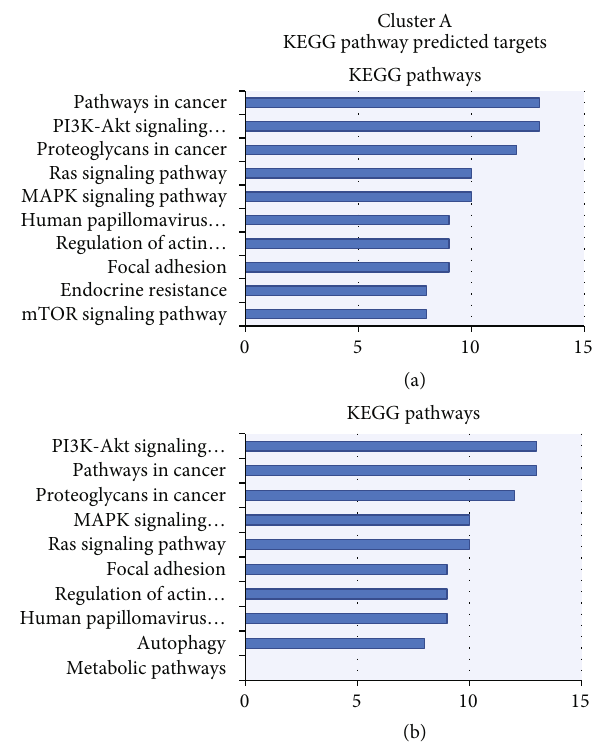
Figure 4: Distribution of enriched KEGG pathways of cluster A: 18 miRNAs consistently deregulated in AbP or recent T1D groups (13 of them being also deregulated in T1D 2-5y). The chart shows category rankings. The X -axis value represents the number of microRNA ’ s targets in the pathway and the Y -axis the pathways. (a) Represents the potential genes from up-expressed microRNAs. (b) Represents the potential genes from down-expressed microRNAs in comparison with controls. AbP group (individuals without diabetes expressing islet autoantibody); recent T1D group (newly diagnosed T1D patients with duration ≤ 6 months); T1D 2-5y group (patients with T1D with 2 to 5 years of duration); IAA: insulin autoantibody; GADA: glutamic acid decarboxylase autoantibody; IA-2A: tyrosine phosphatase autoantibody; ZnT8A: zinc transport 8 autoantibody; only target genes identi fi ed by 20% or more of the DEMs with seed of conserved 7-8 mers were submitted to functional enrichment